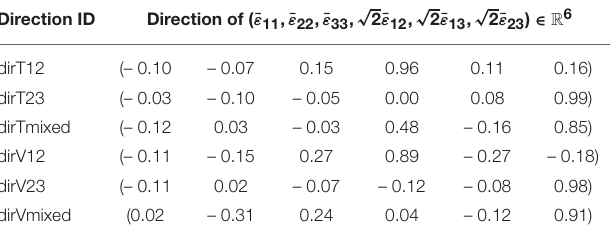
TABLE 2 | Effective strain load directions ¯ ε/ k¯ ε k for the inspection of the effective von Mises stress ¯ σ vM in the evaluation of ANN1. Direction